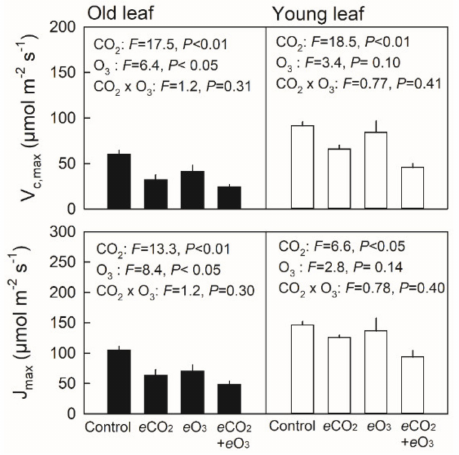
Figure 5. Maximum rates of Rubisco carboxylation (V c,max , upper panel) and RuBP regeneration (J max , lower panel) in old (closed bars) and young leaves (open bars) of Japanese white birch seedlings grown under CO 2 and O 3 treatment combinations. Control—ambient air, eCO 2 —elevated CO 2 , eO 3 —elevated O 3 , and eCO 2 + eO 3 —elevated CO 2 and O 3 . V c,max and J max were normalized to those at 25 ◦ C. Young leaves were ≈ 30 days old, and old leaves were ≈ 60 days old. F -value and probability ( P ) of the effects of CO 2 , O 3 and their interaction are indicated in the panel. Values are mean + SE ( n =